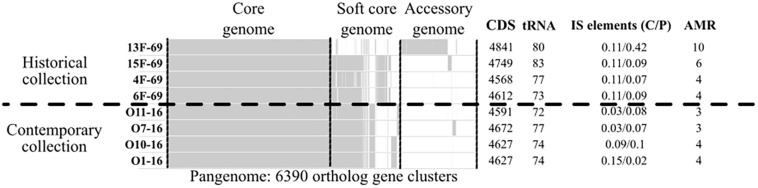
Nullarbor report of the pangenome of the eight Serratia marcescens studied strains, including as additional data the frequency of completely (C) or partially (P) present insertion sequences (ISs), and the number of antimicrobial resistance genes (AMR). Core genome is constituted by genes present in >99% of strains. Soft core genome is constituted by genes present in 99-15% of strains. Accessory genome is constituted by genes present in <15% of strains. CDS, protein-coding sequences.